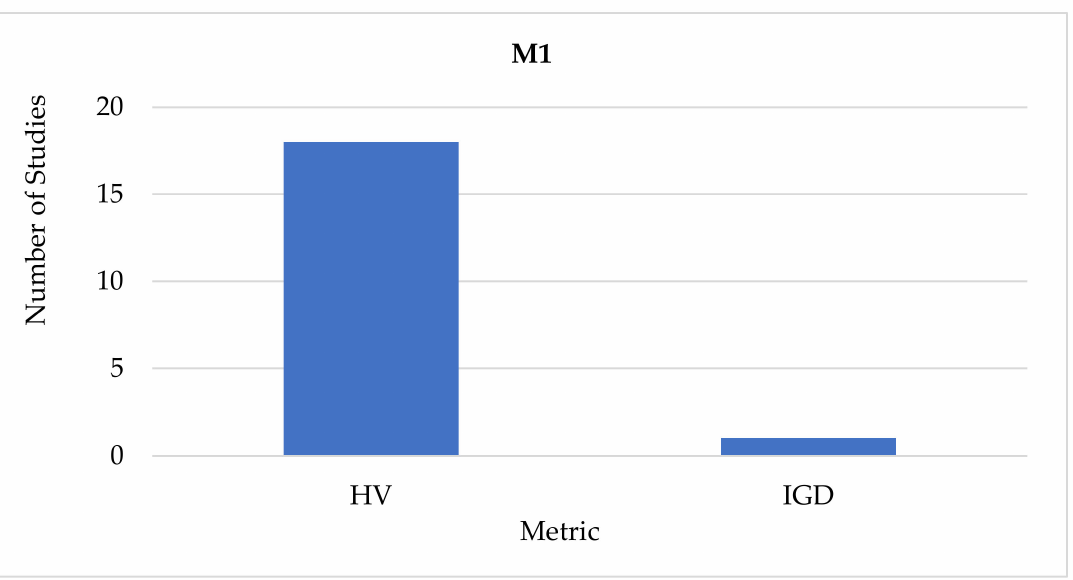
Figure 4. Metrics distribution in M1